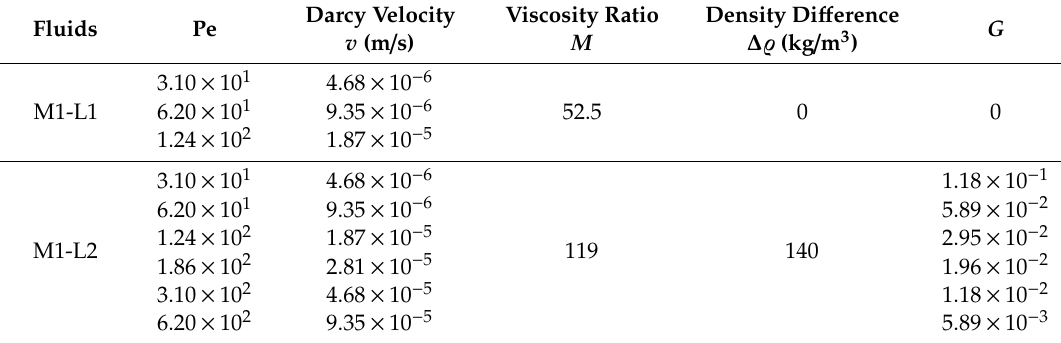
Table 2. Experimental conditions for various sets of more viscous fluids (MVFs) and less viscous fluids (LVFs)